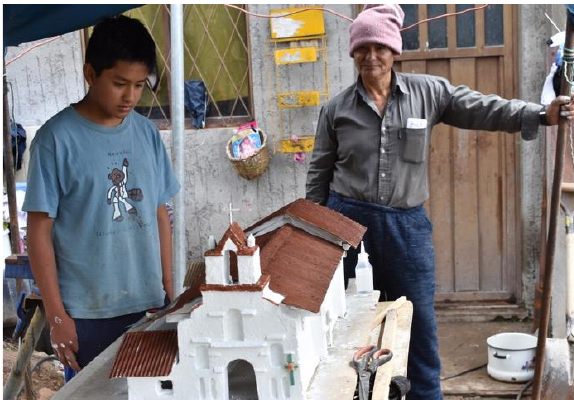
Figure 7. Four months after the workshop, a boy appeared with his own chapel. Source: Photographic Repository of the Ciudad Patrimonio Mundial